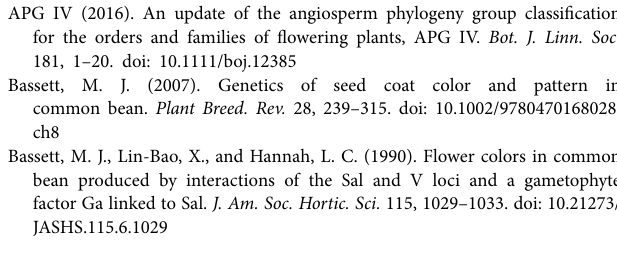
Supplementary Figure S1 | Amino acid alignment of flavonoid 3 ′ 5 ′ hydroxylase proteins for eleven legume species. The sequence divergence between species in the Indigoferoid (common bean, etc.) and Hologalegina (chickpea, etc.) crown nodes [as defined by Lavin et al. (2005)] precluded the discovery of a definitive transmembrane domain. The sequence substrate recognition sites are highlighted in red and CYP450 motifs shared among CYP450 proteins are highlighted in blue. The gene source is listed in Supplementary Table S6